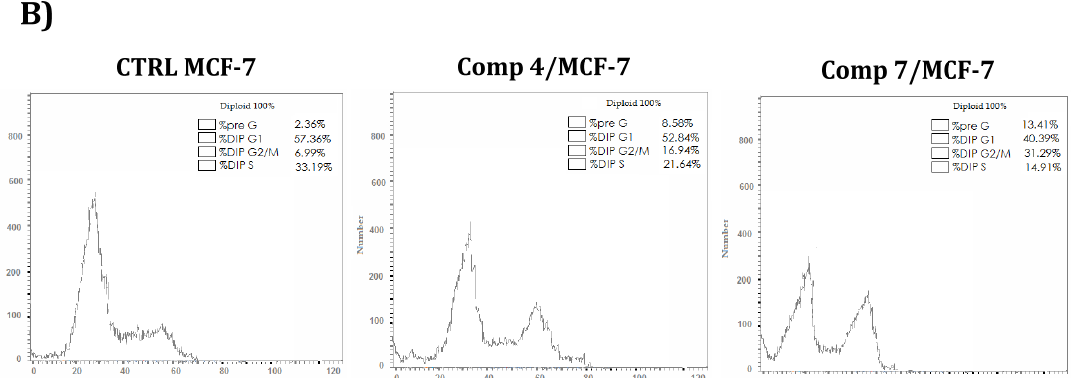
Figure 4. ( A ) MCF-7 cells in untreated control cells and those treated with compounds 4 and 7 are shown in a bar graph. ( B ) Comparing the cell cycle profile of compounds 4 and 7 with that of the untreated control.